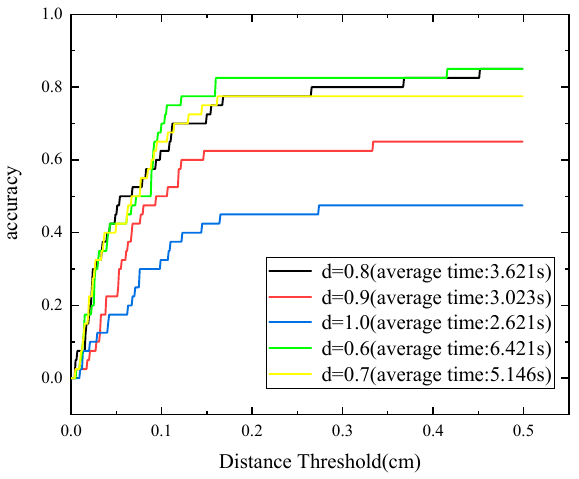
Figure 7. Distance threshold–accuracy curve.